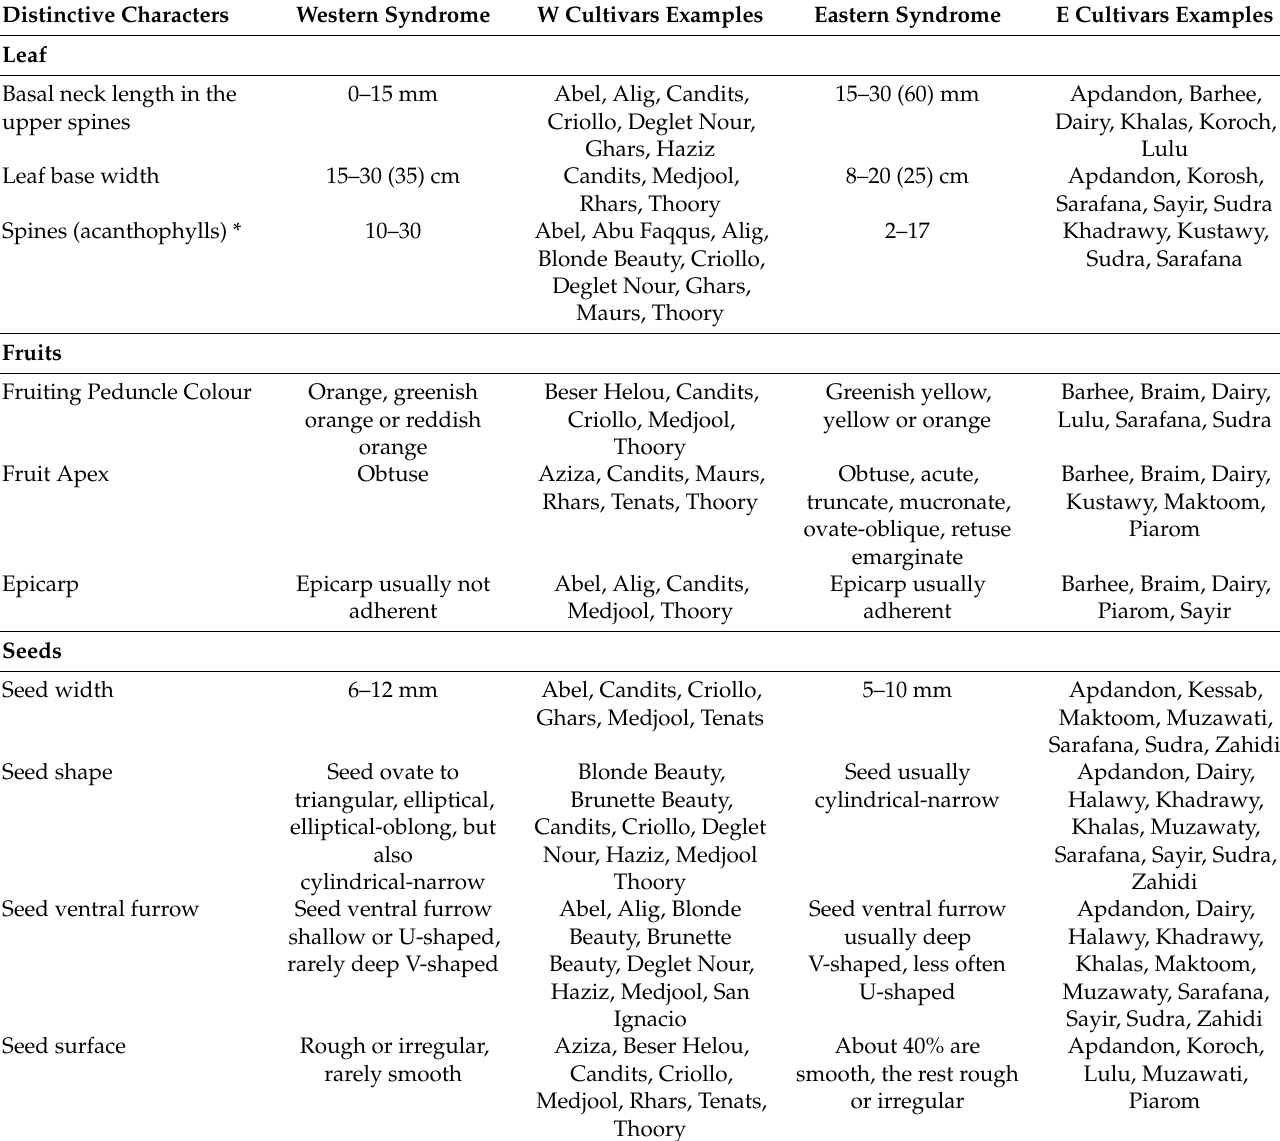
Table 6. Morphological differences between Phoenix dactylifera Western and Eastern